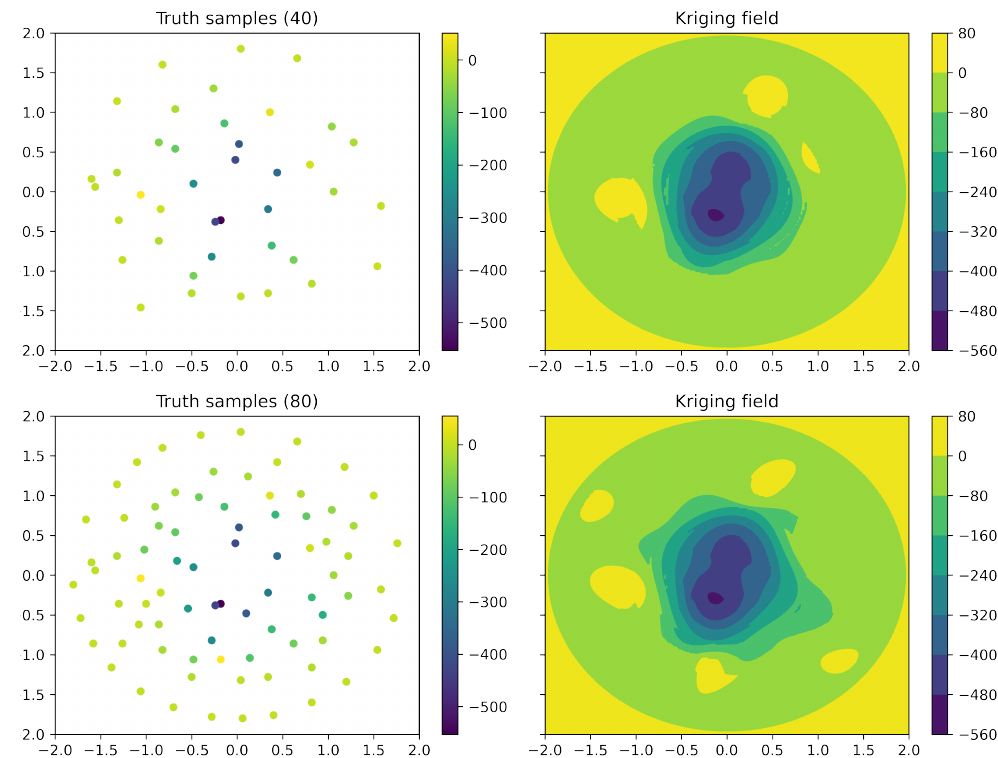
Figure 5. 2D Universal Kriging example after initial random sampling (20 samples), two resampling iterations of 10 samples each (40 samples total), and six resampling iterations of 10 samples each (80 samples total). Test field possesses no